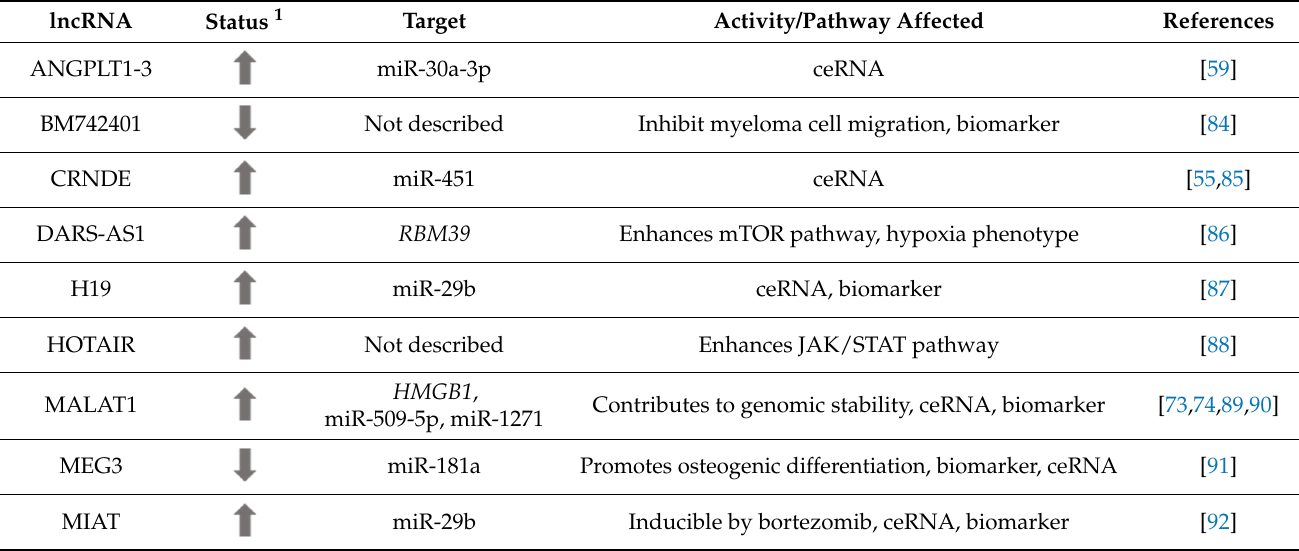
Table 2. lncRNAs that are dysregulated in